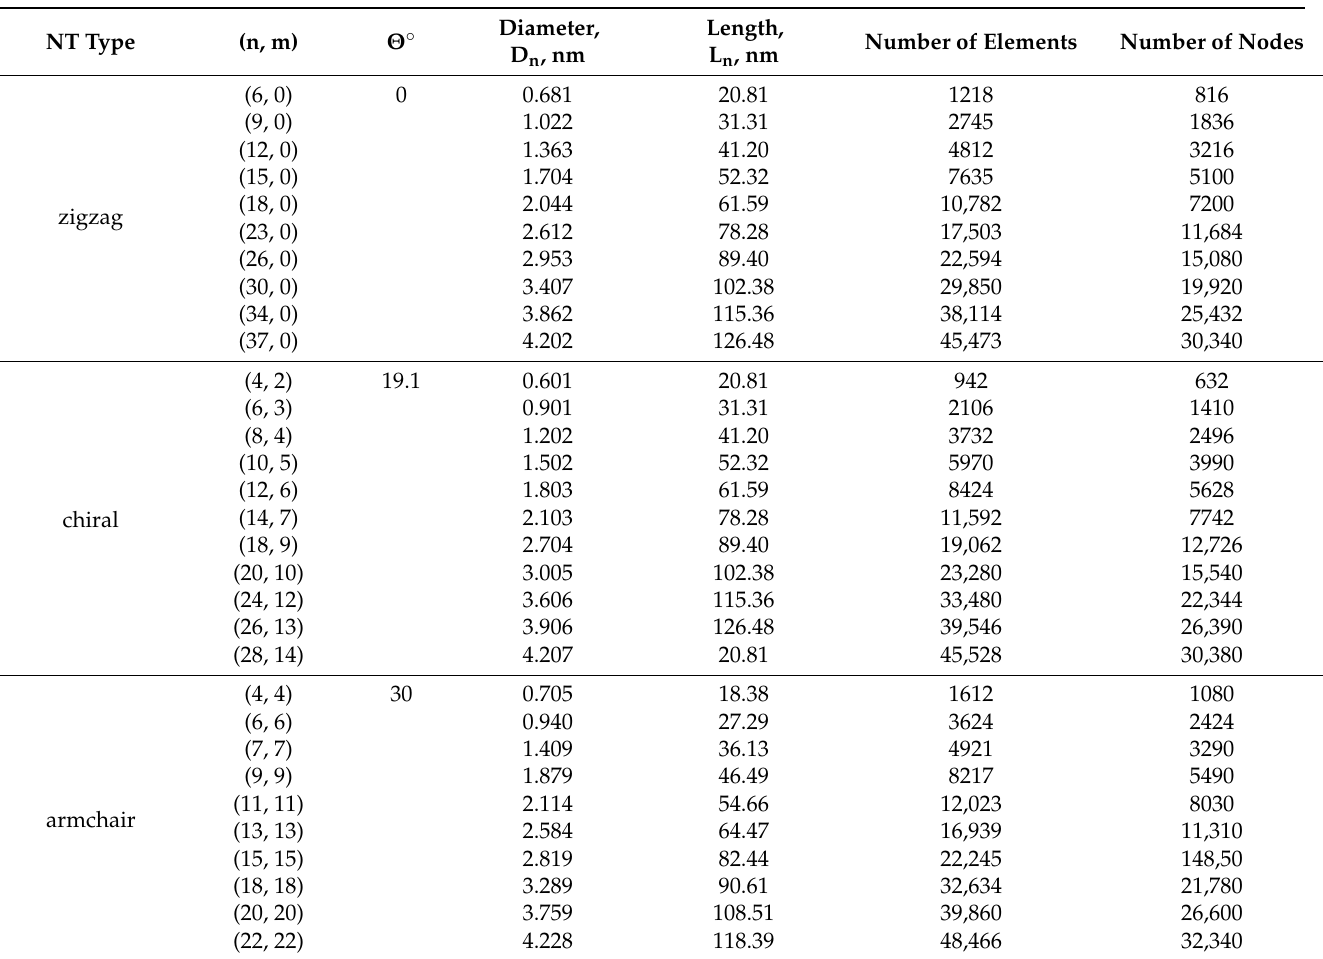
Table 4. Geometrical characteristics of the studied